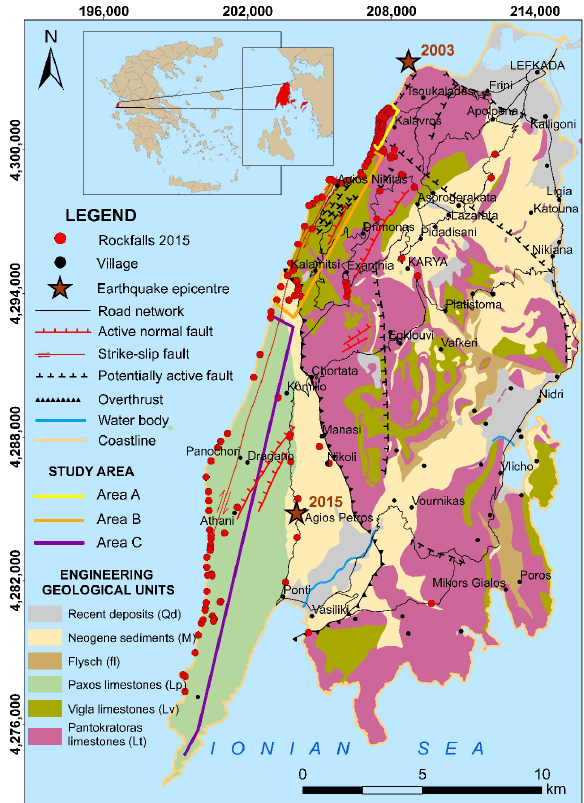
Figure 1. Simplified engineering geological map of Lefkada island with the study locations (map in Greek Geodetic Reference System—GGRS87).